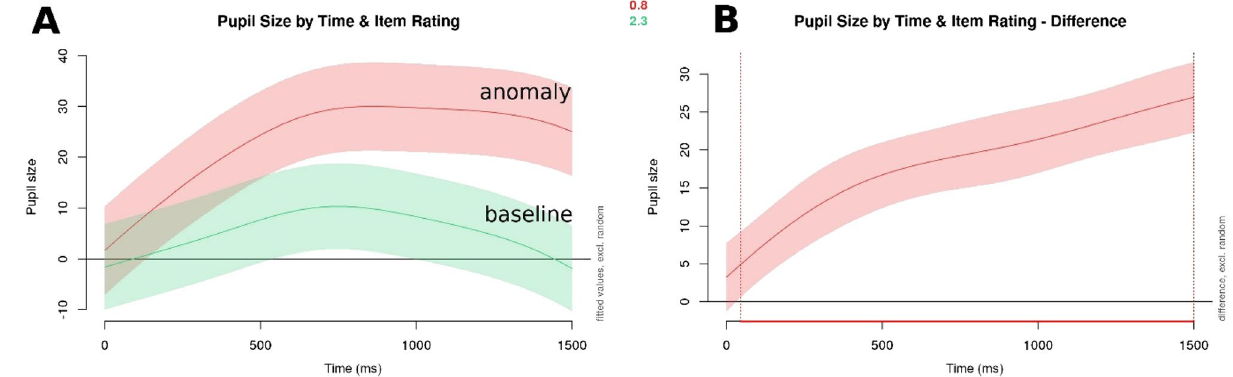
Figure 3. Visualizations of pupil size by item rating over time (in ms since target word onset). Panel A shows baseline (green/lower curve) vs. semantic anomaly condition (red/upper curve), and Panel B visualizes the difference between the two, with the red line on the x-axis (below the plot) highlighting the time frame where the difference in pupil size between the baseline and error conditions is significantly different. The shaded areas denote a 95% confidence